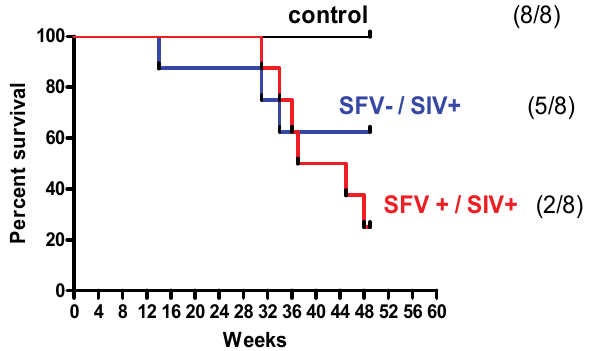
Figure 5. Monkey survival curves. The Log-rank (Mantel-Cox) test indicated the difference in the survival curves as p = 0.0217 at 49 weeks after